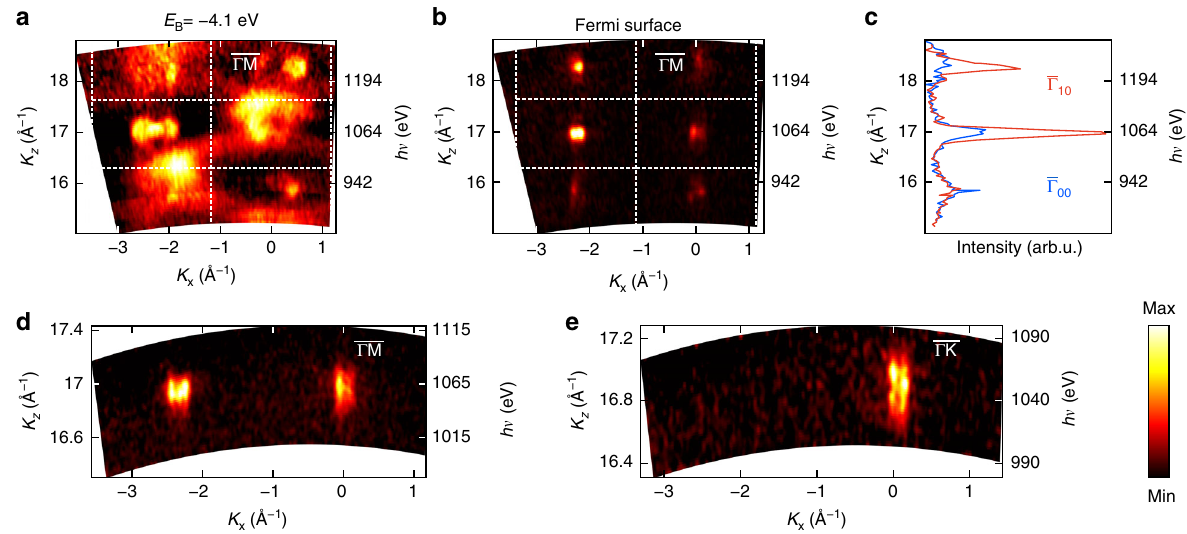
Fig. 3 ARPES response of the 2DEG as a function of K z momentum. ARPES intensity along the indicated azimuths is plotted as a function of K z rendered from hv (the indicated hv values correspond to the Γ -point) a Iso- E B map near the VBM, showing 3D contours of the VB states. b FS formed by the QWSs. c E Γ - and Γ -points, showing periodically oscillating response of the QWSs. Its peaks located in the Γ -points evidence that the QWSs F -MDCs at the 00 10 inherit their wavefunction from the CBM of parent bulk GaN. Zoom-in of the FS at the Γ 00 - and Γ 10 -points along the Γ M d and Γ K e measured at around 1070 eV. The absence of its K z dispersion con fi rms the 2D character of the